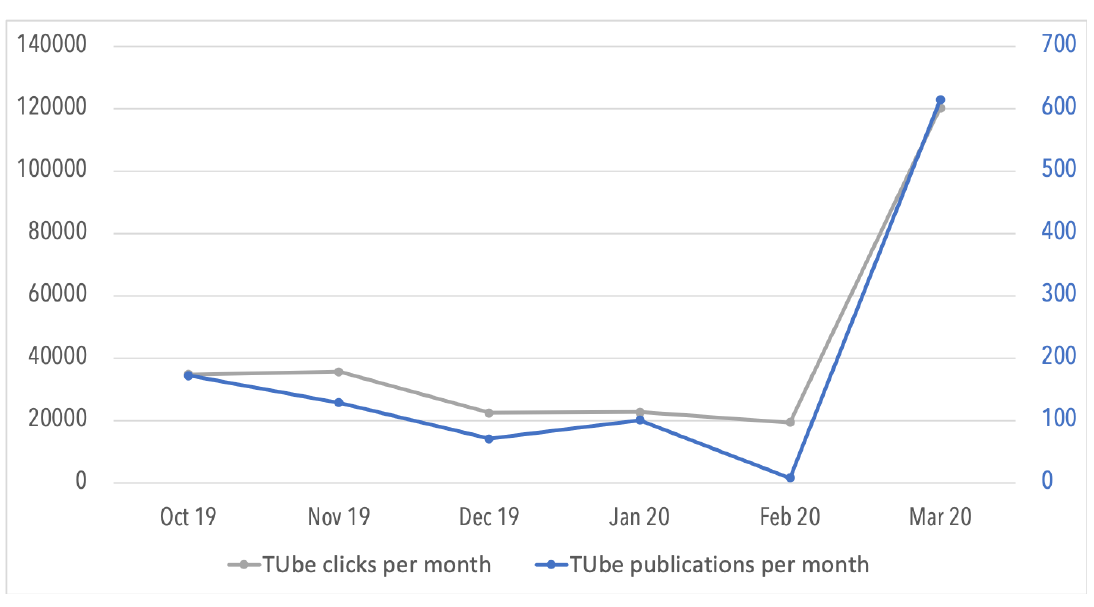
Figure 6. Sum of TUbe views and TUbe publications per month from October 2019 to March 2020. Source: Graz University of Technology, Educational Technology.